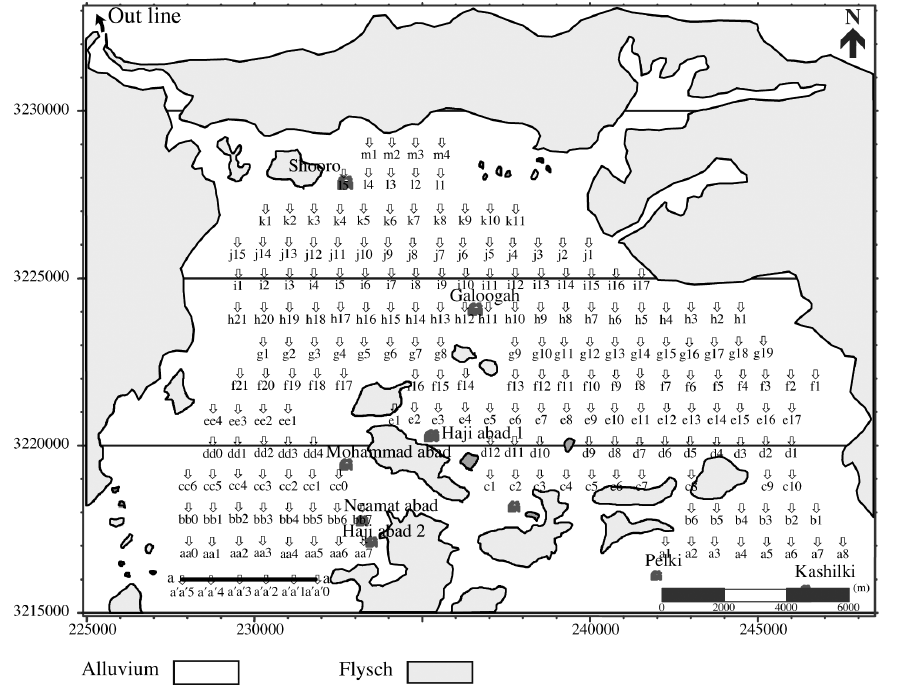
Fig. 2. The location of VES and aa l